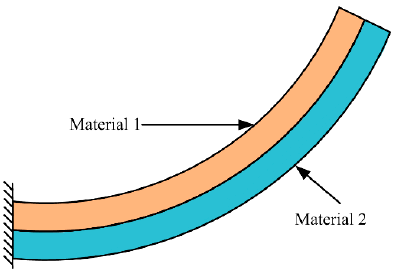
Figure 25. Electrothermal bimorph structure.